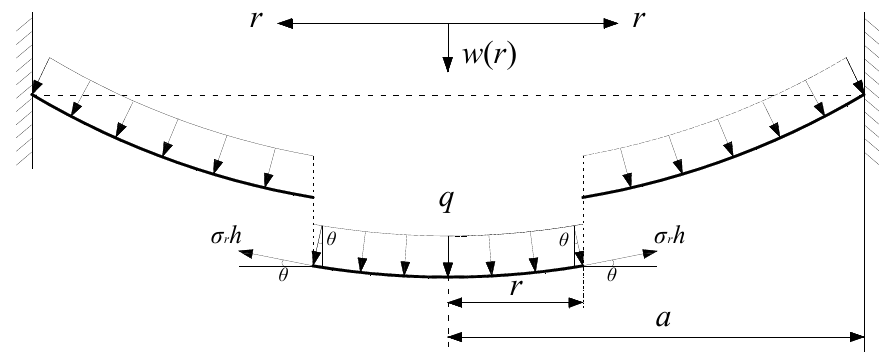
Figure 4. The equilibrium diagram of the central portion ( r < a ) of the circular membrane.